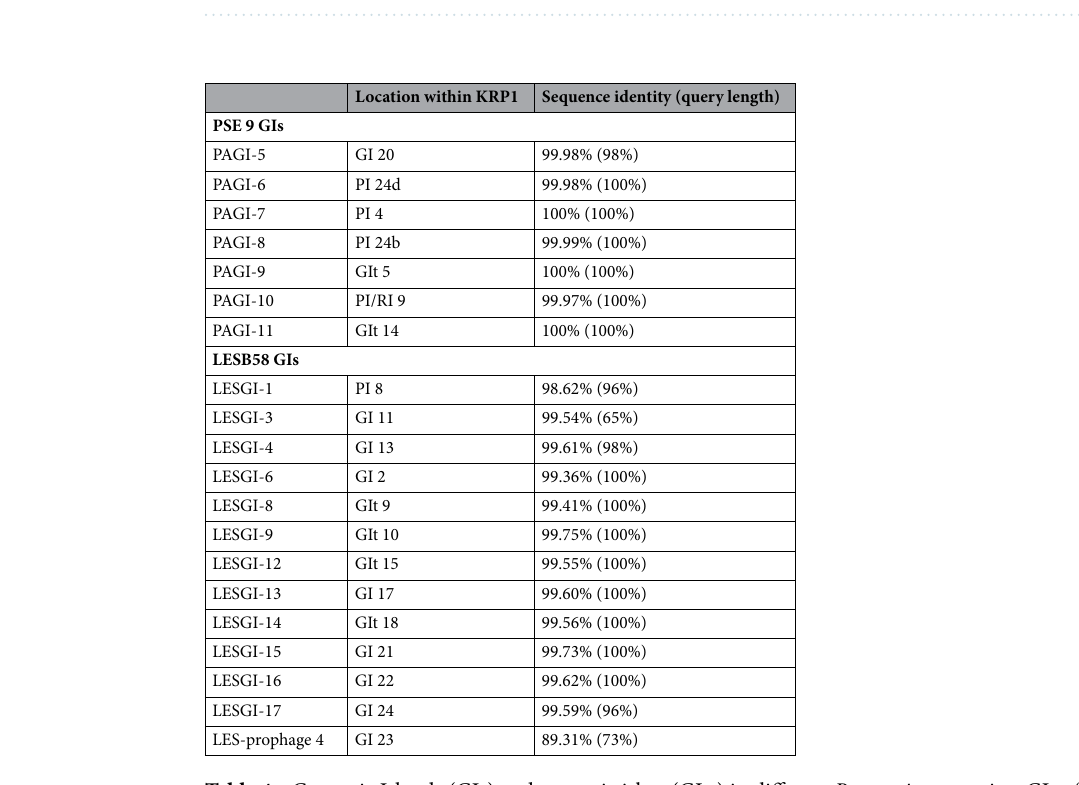
Table 4. Genomic Islands (GIs) and genomic islets (GIts) in different P. aeruginosa strains. GIs of strain PSE9 and selected GIs of strain LESB58 and their corresponding GI and GIts, as well as sequence similarity within the strain